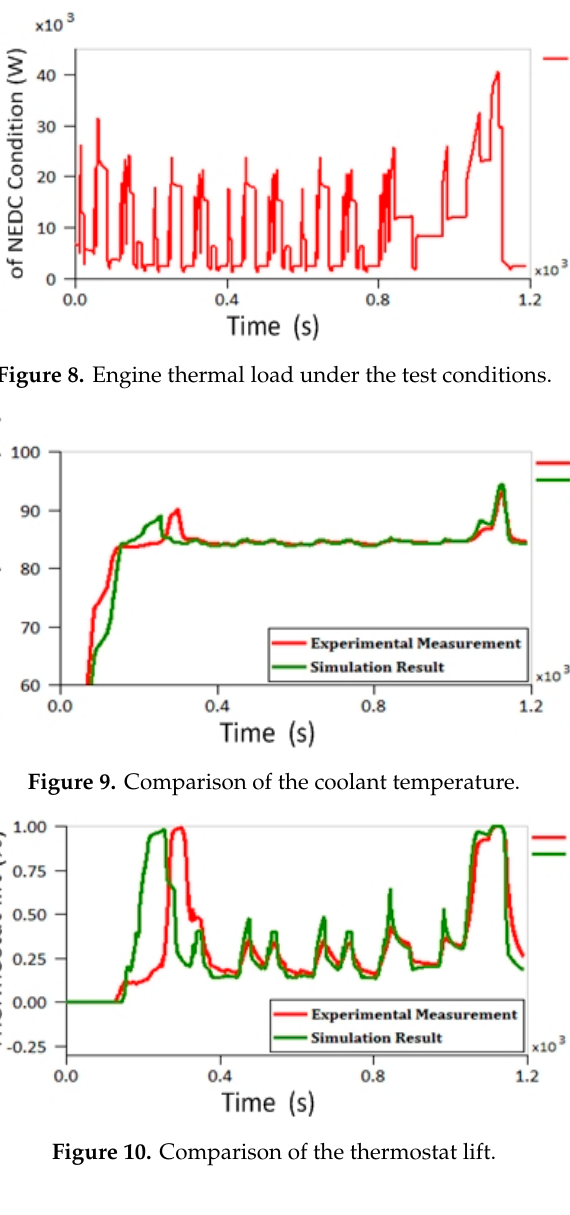
Figure 7. Engine speed, fuel consumption rate, and brake mean effective pressure.